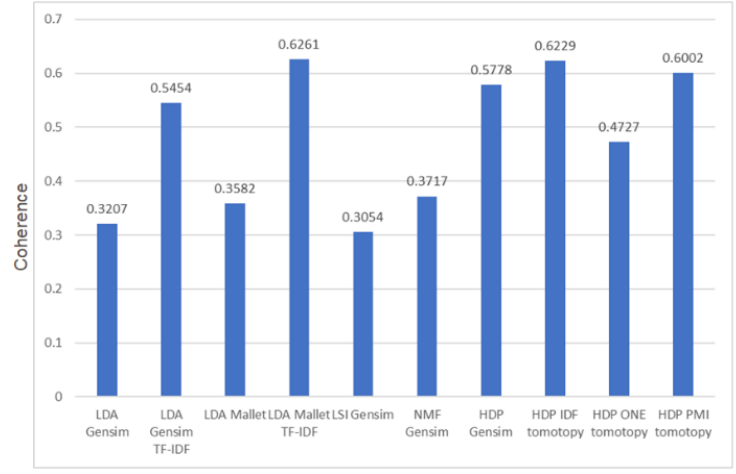
Figure 10. Comparison of LDA and HDP perplexity [32].